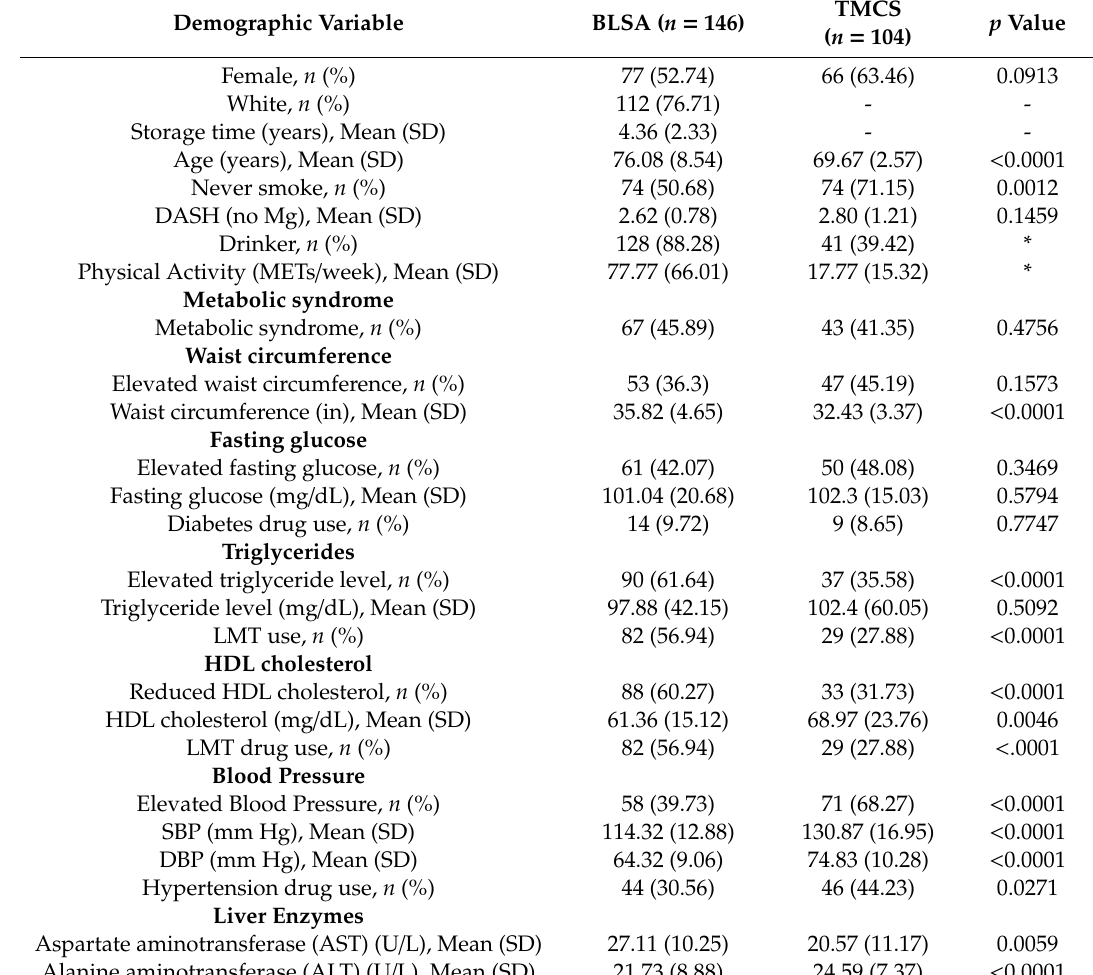
Table 1. Participant